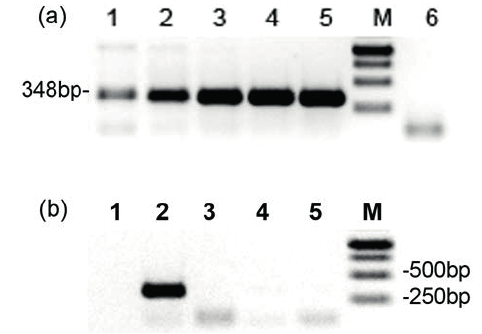
Fig. 5. Detection of Rcc DNA in barley cv. Fridericus plants (seeded from the 2015 harvest) in controlled environment. (a) Artificially infected barley at GS 75 in leaves: 1. flag leaf; 2. F-1; 3. F-2; .4 F-3; 5. positive control (100 pg of Rcc DNA); M. 1.0 kb DNA ladder Plus (Thermo Scientific); ,6. negative control (SDW). (b) Not-infected barley: 1. negative control (SDW); 2. positive control (100 pg of Rcc DNA); 3. GS 13; 4. GS 25; 5. GS 75; M. 1.0 kb DNA ladder Plus (Thermo